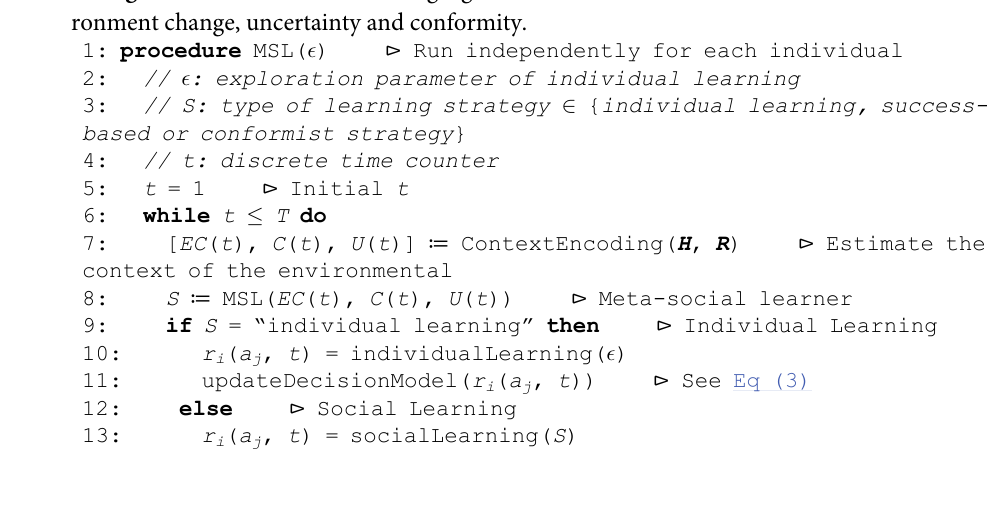
Algorithm 2 Meta-social learning algorithm based on the environmental variables: envi- ronment change, uncertainty and